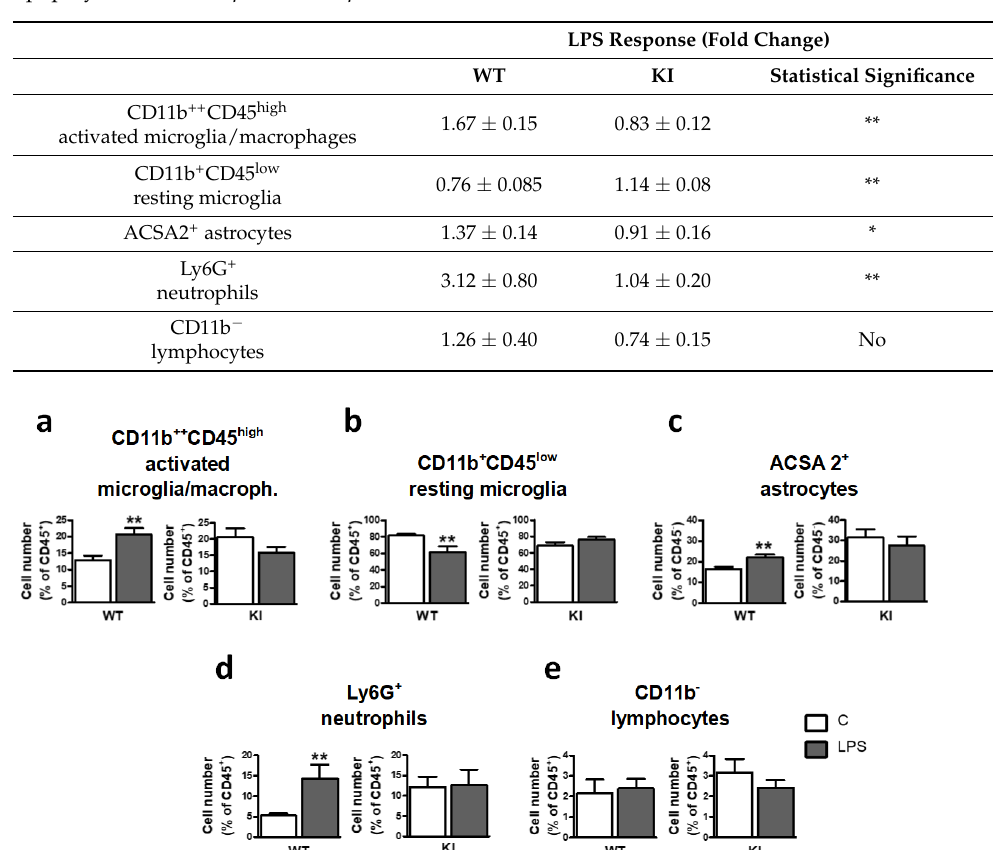
Table 1. Differences in LPS effects between WT and GSK3 β Ser 389 KI mice. Values represent cell number after LPS treatment in each genotype and are expressed as an increase with respect to vehicle- treated controls (mean ± S.E.M). Asterisks indicate statistically significant differences between the effects of LPS in WT and GSK3 β Ser 389 KI animals. WT, wild-type; KI, GSK3 β Ser 389 knockin; LPS, lipopolysaccharide. *, p < 0.05; **, p < 0.01.